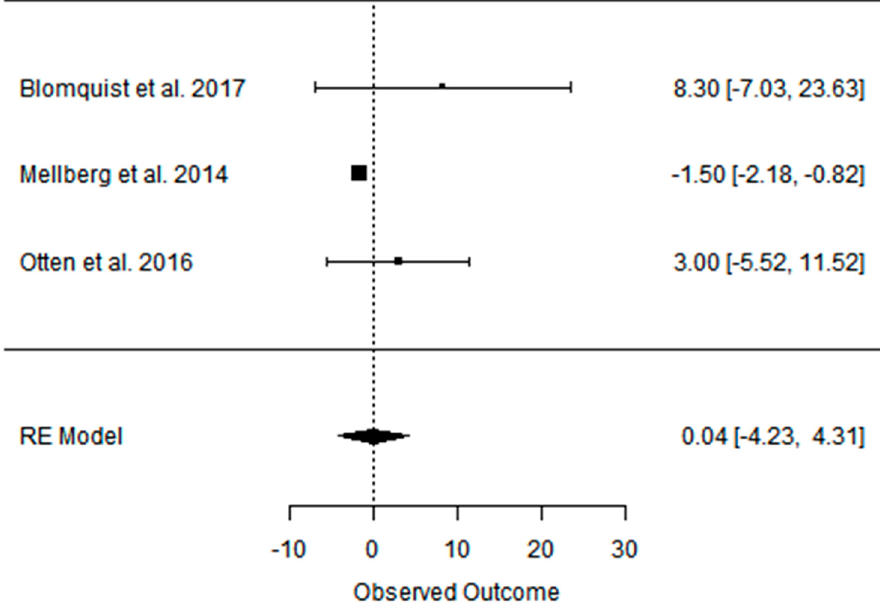
Figure A42. Forest plot of the effect of a PD on DBP in the long term (weighted mean difference).